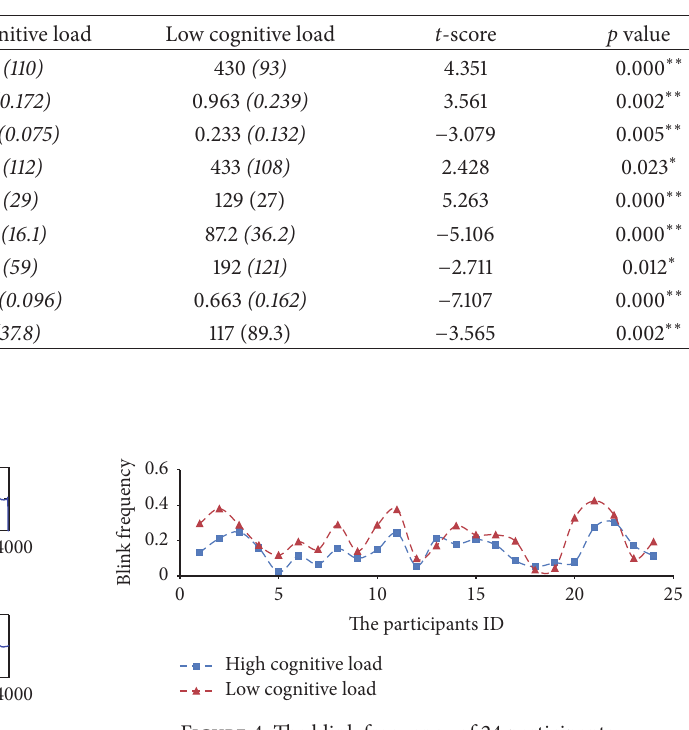
Table 2: The salient features in light change condition.